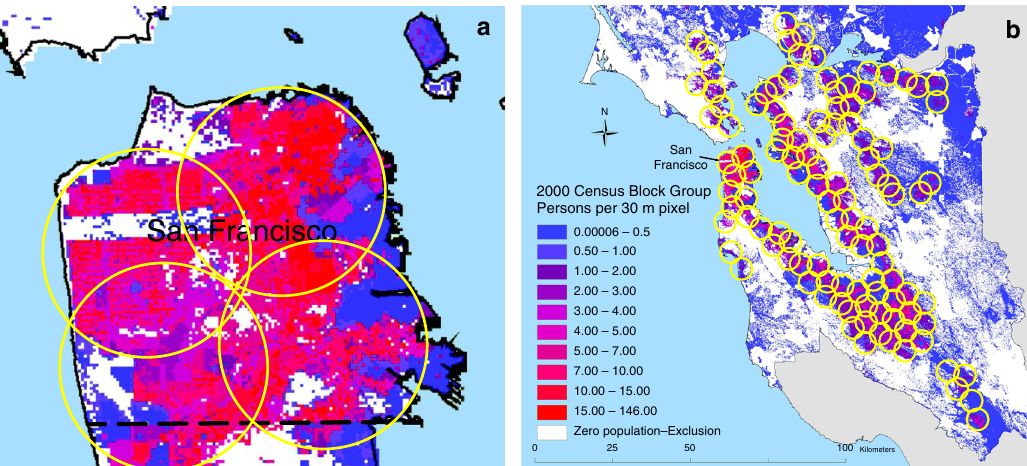
Fig. 3 Example coverage of drone delivery systems. a coverage with the base-case quadcopter range (3.5 km) in the city of San Francisco, CA, USA, and b in the populated areas of the San Francisco Bay Area. Legend indicates population density in the underlying map, which is based on the 2000 U.S. Census 70 . As shown, roughly four local warehouses or waystations (indicated by a yellow circle) would be required to service the small, dense city of San Francisco and up to 112 warehouses or waystations would be required to cover the greater Bay Area